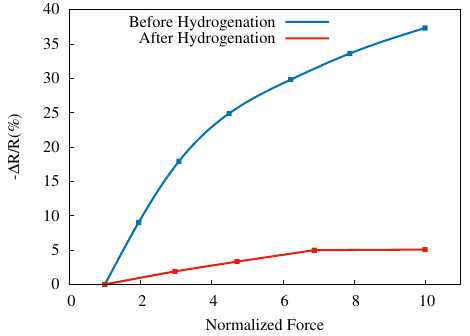
Figure 7. SiNWs PZR response for sample D before and after hydrogenation.